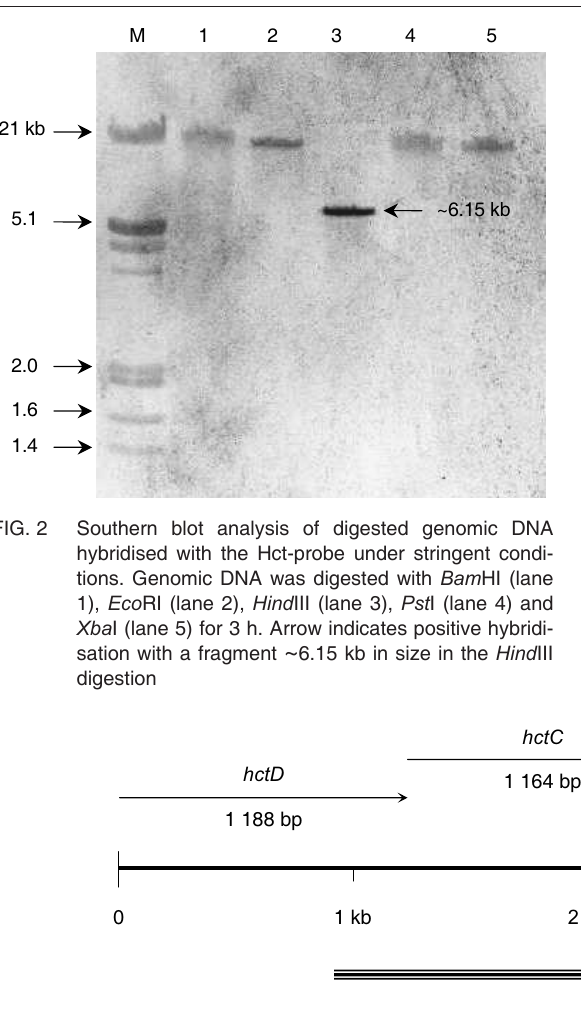
FIG. 4 Genetic map of the capsule transport gene region of H. paragallinarum . The locations and directions of transcription of the four open reading frames hctDCBA are indicated. The 2.6 kb fragment (Hct) used as the DNA probe in Fig. 2 is also